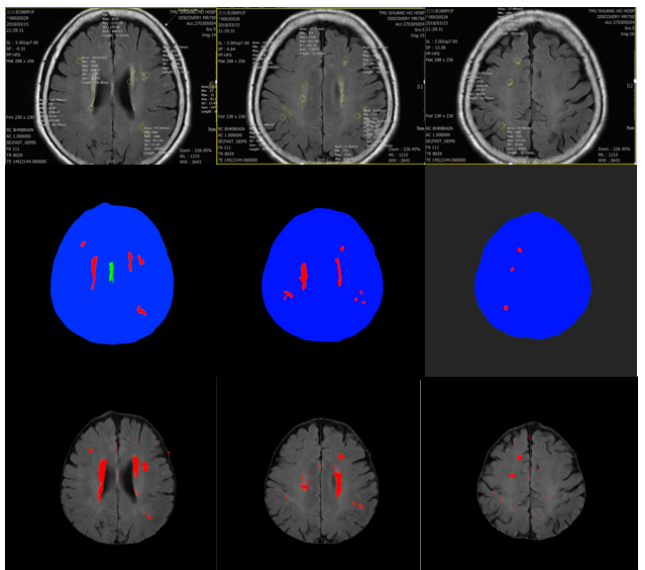
Figure 8. ( Top ) image marked by the physician, ( middle ) ground-truth drawn according to the position marked by the physician, ( bottom ) image output by the CNN model.